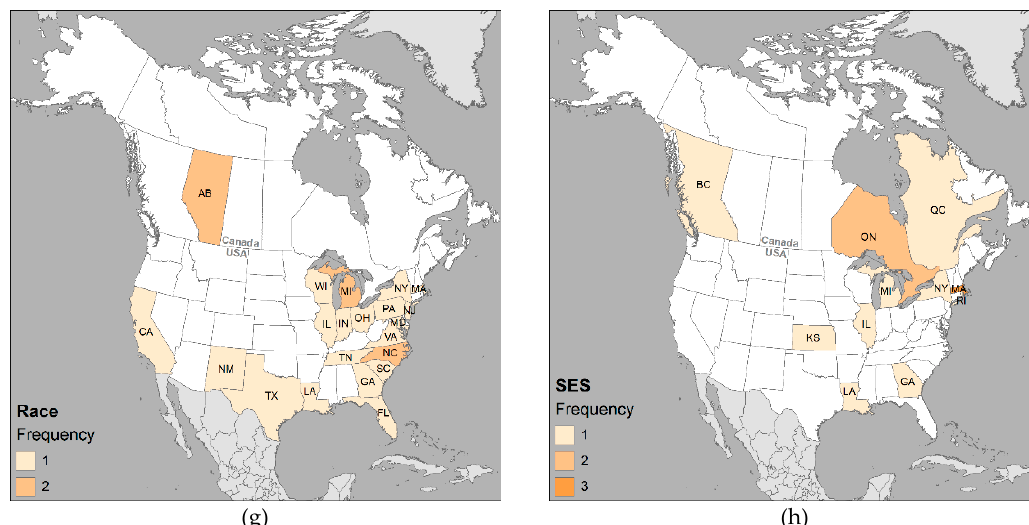
Figure 9. Geographic distribution of the most frequently published categories of ( a ) air pollution; ( b ) chemical; ( c ) agriculture; ( d ) vegetation; ( e ) waste site; ( f ) water contamination; ( g ) race; and ( h ) SES. Frequency classes standardized across all maps to intuit where the health issue is of interest (1), emerging (2), concern (3), or potential problem (4 or more).